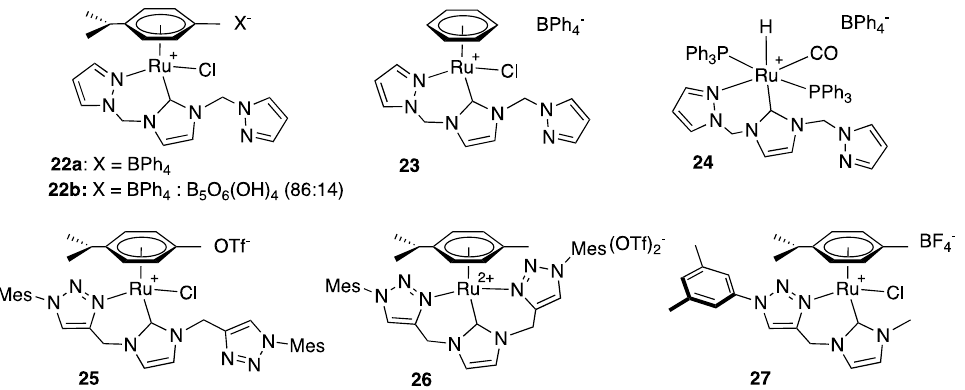
Figure 4. Triazole- and pyrazole-functionalized imidazole-2-ylidene complexes 22 – 27 .